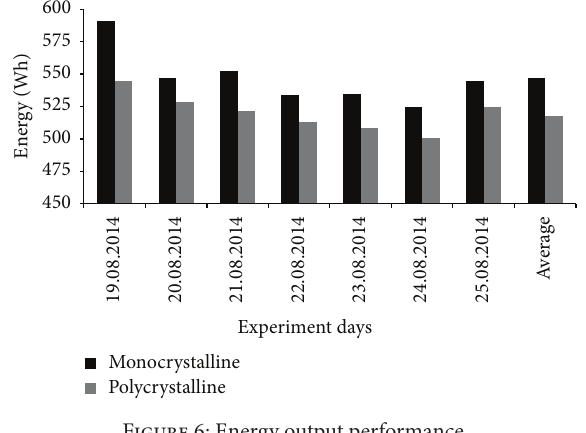
Figure 6: Energy output performance.